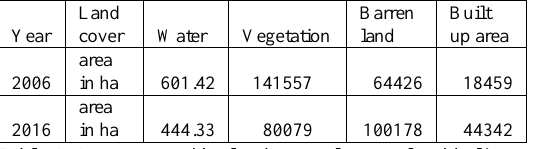
Table 1: Area covered by landcover classes of Uchhali wetlands